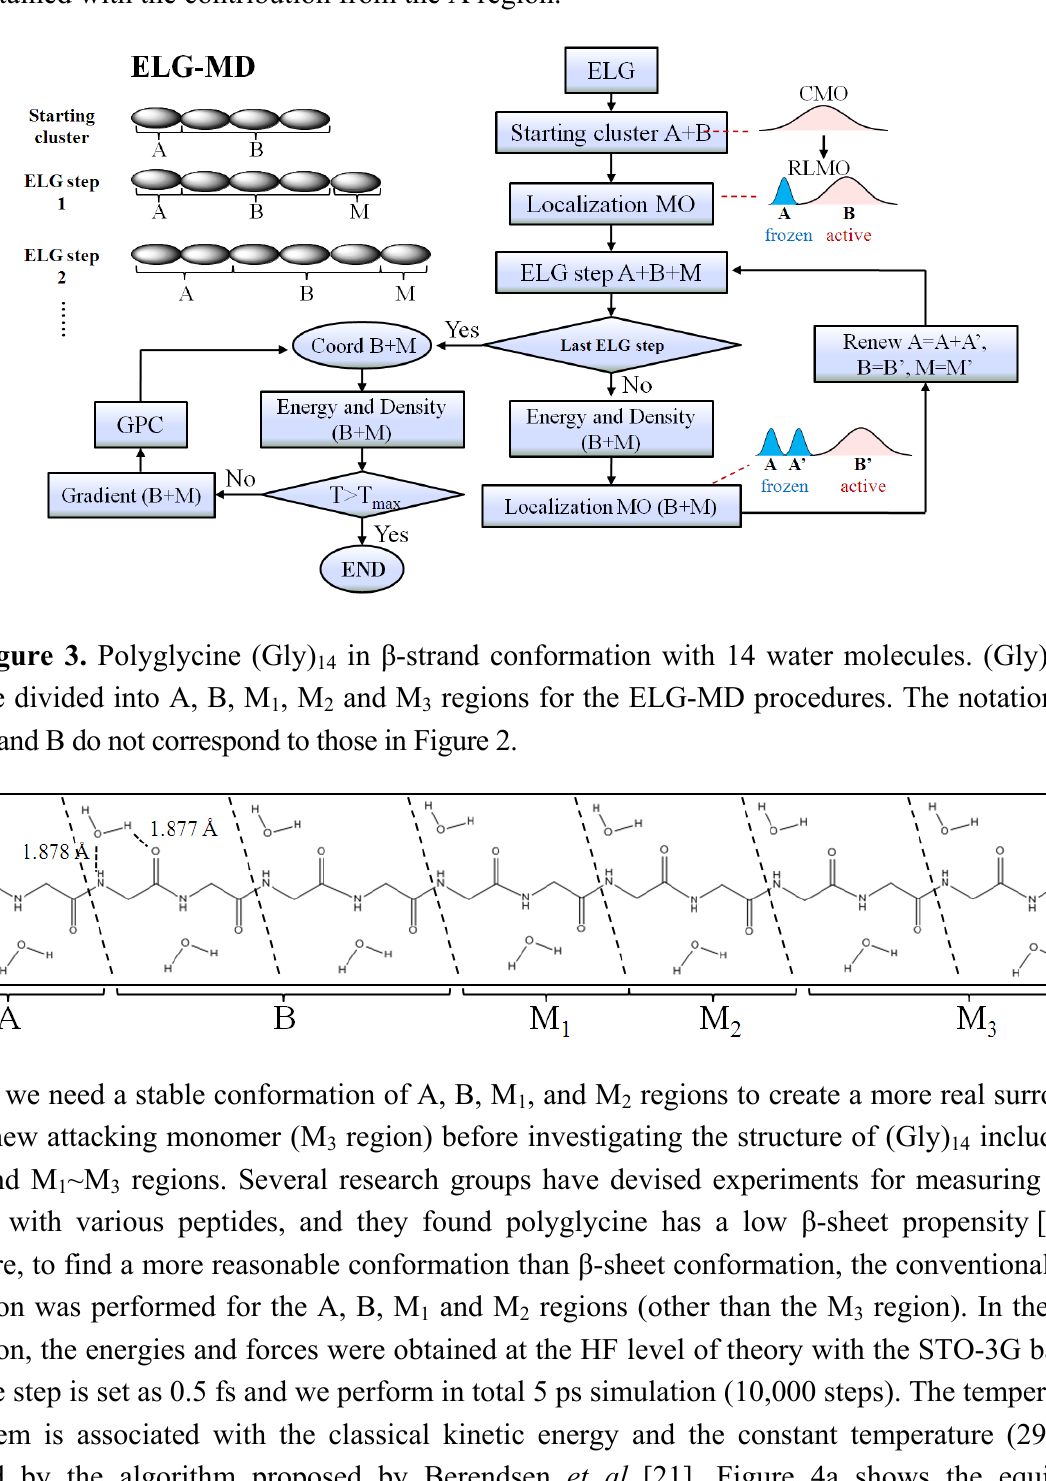
obtained with the contribution from the A region.